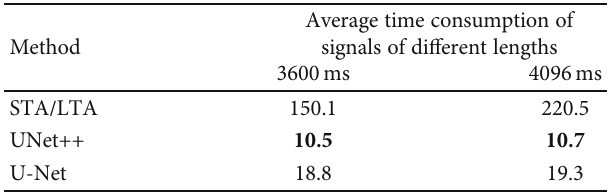
Figure 22: First-arrival picking result of the signal shown in Figure 21(a). (a) Local ampli fi cation of the signal in the range from 430ms to 530ms; (b) The picking result in the signal band from 430ms to 530ms obtained by the UNet++. (c) The picking result in the signal band from 430 ms to 530ms obtained by the U-Net. (d) The picking result obtained by STA/LTA in the signal band from 430 ms to 530 ms, where the long- and short-time windows were 300 and 100, respectively. Table 3: Picking time spent comparison of UNet++, U-Net, and